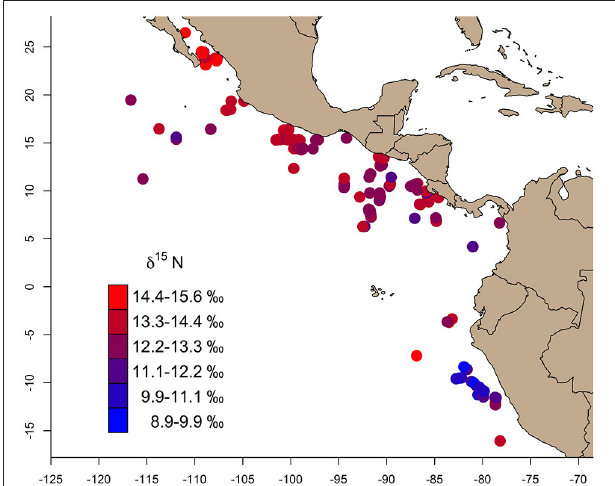
FIGURE 2 | The gradient of bulk skin tissue δ 15 N values from olive ridley turtles sampled across the study area ranged from 8.9 to 15.6 ‰ . In general, δ 15 N values increased from south (Peru Current) to north (Gulf of California).